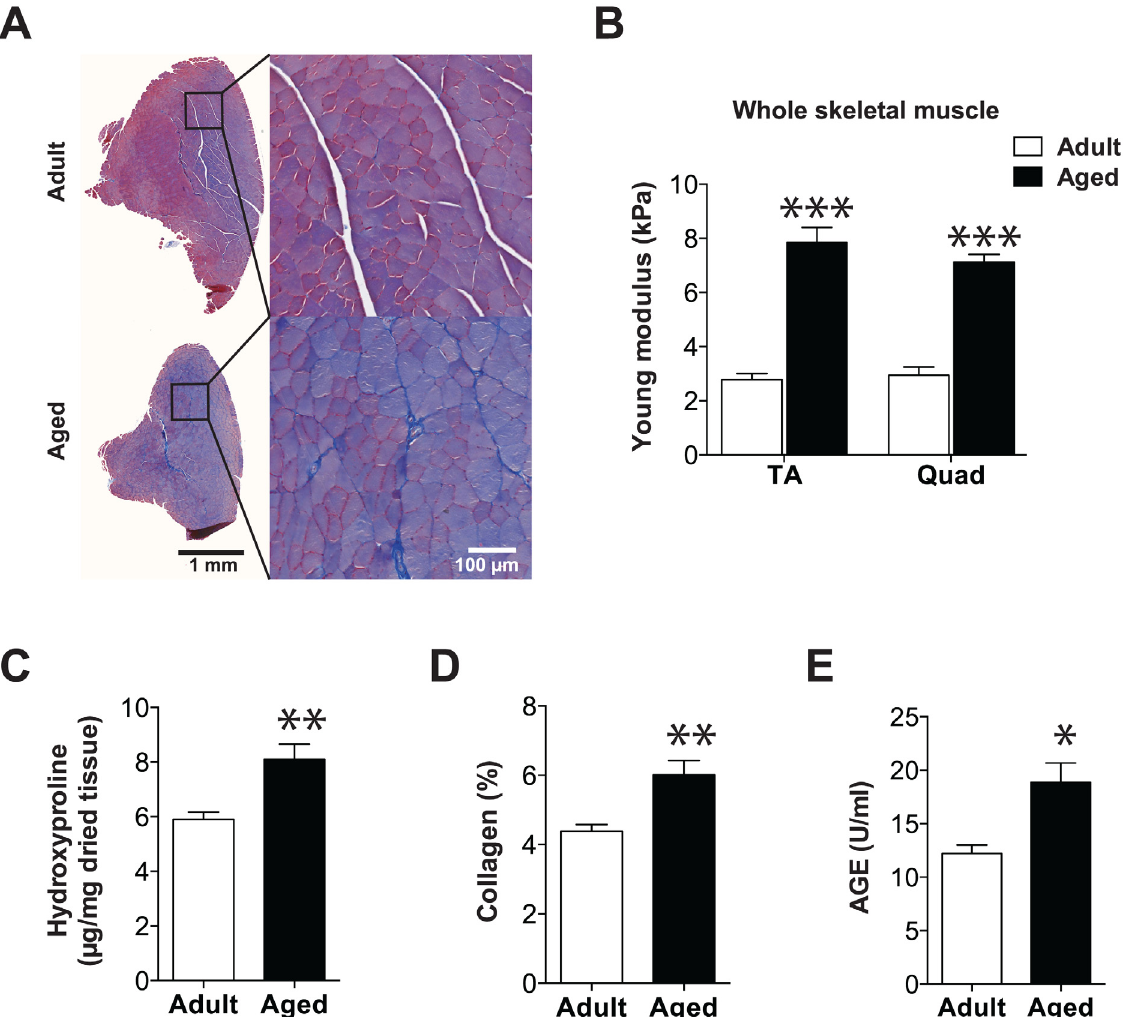
Fig 2. Aging is associated with increased skeletal muscle stiffness. (A) Representative images of Masson trichrome-stained TA sections from adult and aged male C57Bl/6 mice. (B) Graph showing the quantification of whole muscle stiffness from 100- μ m-thick slices of TA and Quad muscles from adult ( n = 4) and aged ( n = 7) mice. Ten measurements per slice with three force-indentation curves collected per measurement were performed on 3 – 5 sections for each mouse. ( C ) Graph showing the biochemical quantification of total hydroxyproline content of Quad muscles from adult ( n = 5) and aged ( n = 5) mice. (D) Graph showing hydroxyproline values converted to collagen content. ( E ) Measurement of total advanced glycation end-product (AGE) content of Quad muscles from adult ( n = 5) and aged ( n = 5) mice. * p < 0.05; ** p < 0.01; *** p < 0.0001 versus adult group. All data are expressed as means ±